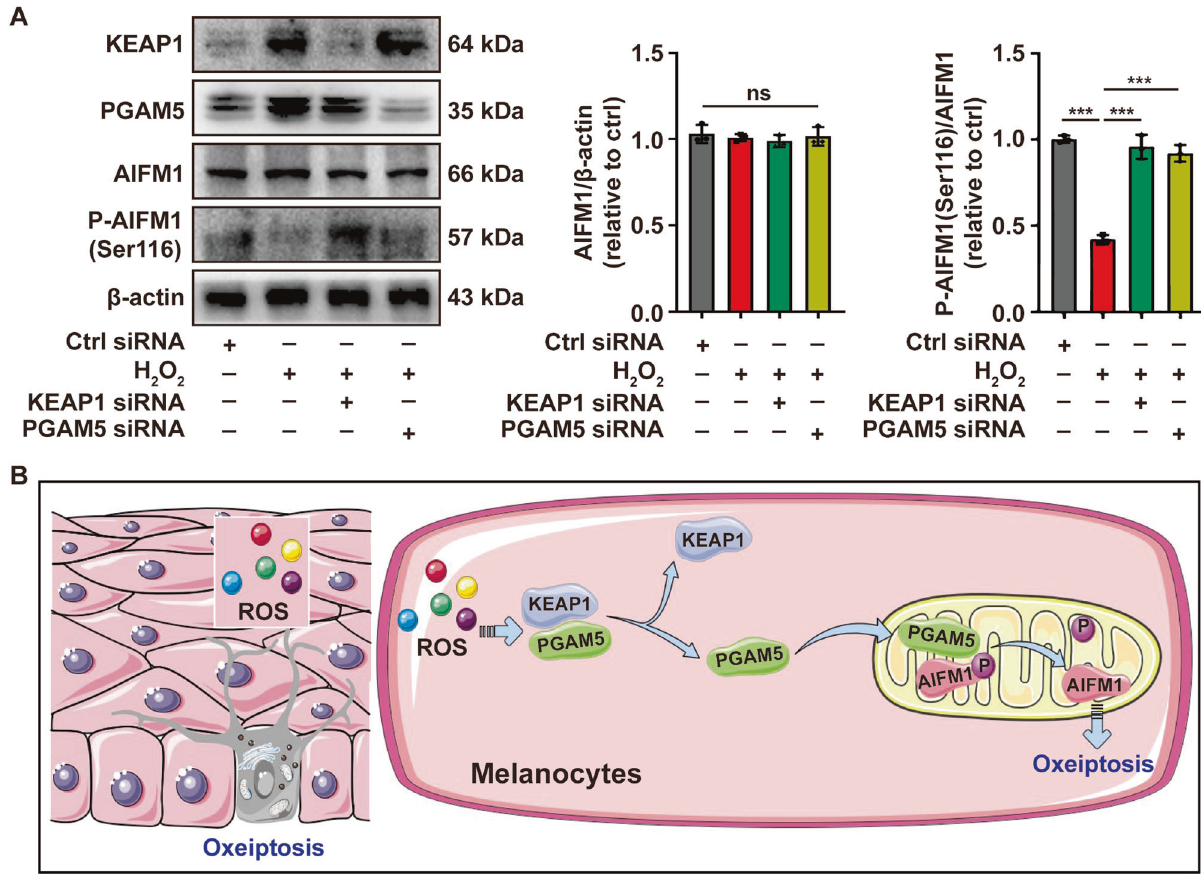
Fig. 6 Oxeiptosis is activated by oxidative stress in melanocytes. A The analysis of AIFM1 phosphorylated at Ser116 in PIG1 cells pretreated with KEAP1 siRNA or PGAM5 siRNA, followed by treatment with H 2 O 2 , determined by Western-blot assay. B The diagram of the oxeiptosis in melanocytes under oxidative stress. *** P < 0.001, ns: not signi fi